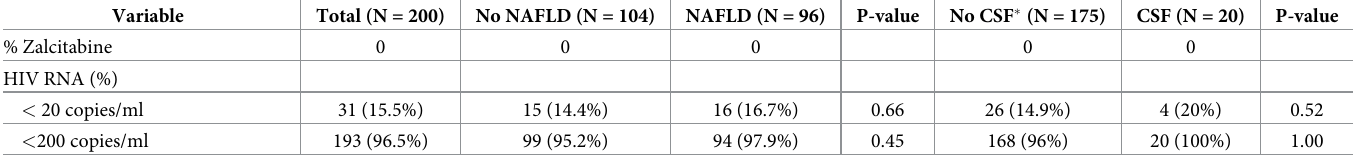
race, non-Hispanic ethnicity, higher triglycerides levels, insulin levels, and absolute and nadir CD4 + T cell counts were associated with worse MCS, whereas older age, higher BMI, and larger waist circumference were associated with better MCS scores. On multivariate analysis Table 3, diabetes was the only independent variable negatively associated with PCS in PWH, whereas Hispanic ethnicity (positively) and nadir CD4 + T cell counts (negatively) were independently associated with MCS in PWH. Characteristics of participants with HIV-NAFLD compared to those with primary NAFLD There were distinct differences in the characteristics of participants with NAFLD between the two groups ( S2 Table ). Participants with HIV-NAFLD, compared to those with primary NAFLD, were less frequently cisgender females (18.4% vs 62%), White (71.3% vs 94.3%), and Table 2. Summary and individual scores on the SF-36 questionnaire in persons with HIV. Variable (N = 200) Overall No NAFLD Mean (SD) (N = 104) Physical component summary score